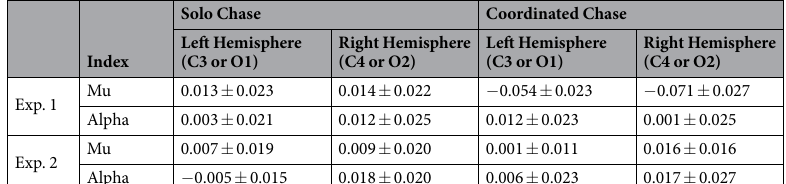
Table 2. Mu and Alpha indices for all conditions (mean ±